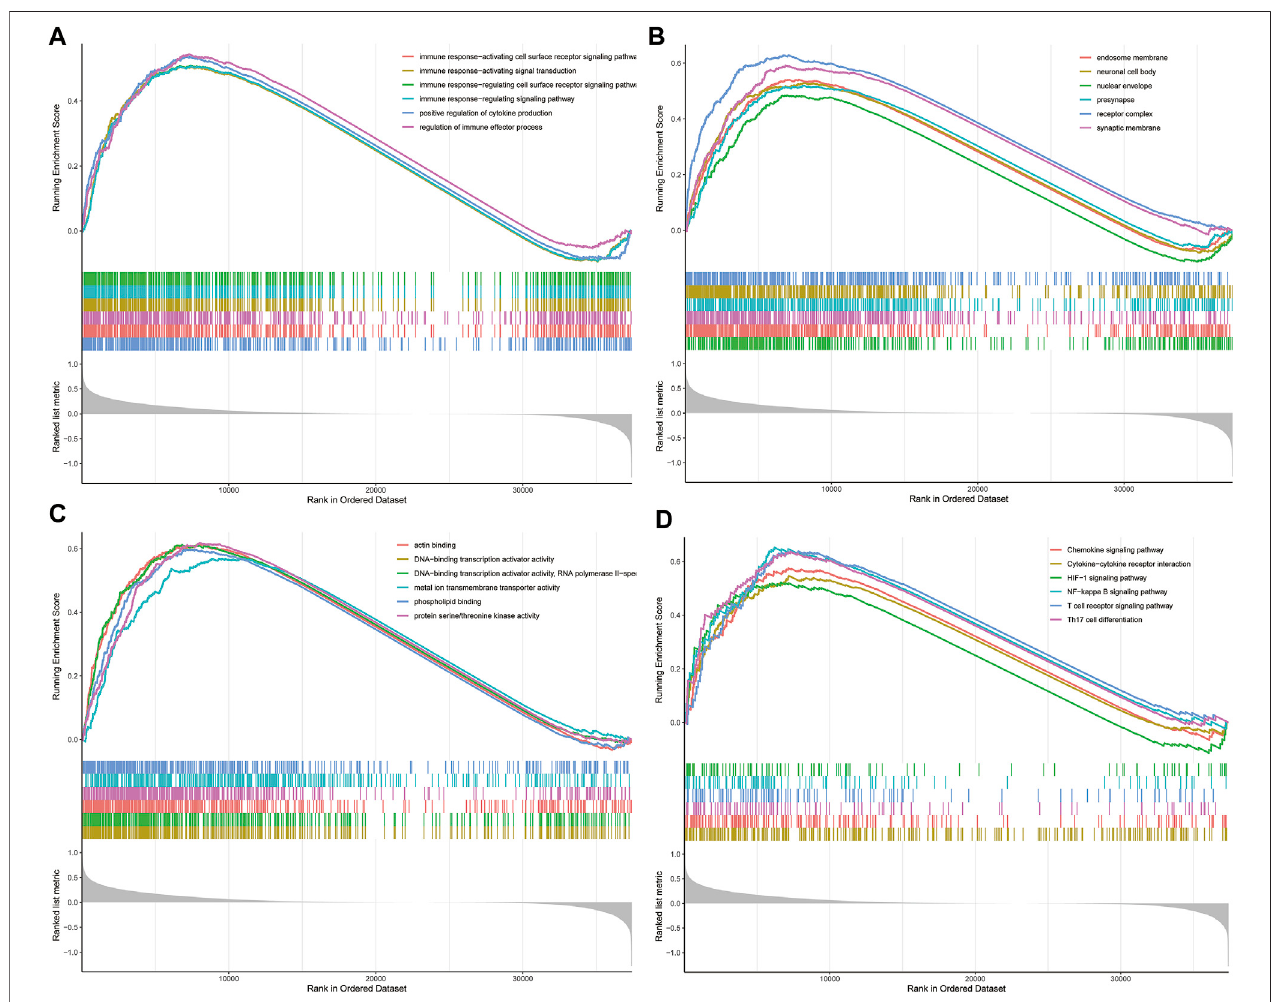
FIGURE4| GSEAanalysisinTCGAdataset. (A) Theenriched genesets inGO-BP categorybytheDEGsbetweenthetworiskgroups. (B) Theenriched genesets inGO-CCcategorybytheDEGsbetweenthetworiskgroups. (C) EnrichedgenesetsinGO-MFcategorybytheDEGsbetweenthetworiskgroups. (D) Enrichmentplot of the DEGs between the high- and low-risk groups using GSEA-KEGG. Each line representing one particular gene set with unique color, and up-regulated genes located in the left approaching the origin of the coordinates, by contrast the down-regulated lay on the right of x -axis. Only gene sets with adjusted p < 0.05 were considered signi fi cant. And only several leading gene sets were displayed in the plot. GSEA, gene set enrichment analysis; GO, Gene Ontology; BP, biological process; CC, cellular component; MF, molecular function; DEGs, differentially expressed genes; KEGG, Kyoto Encyclopedia of Genes and Genomes.